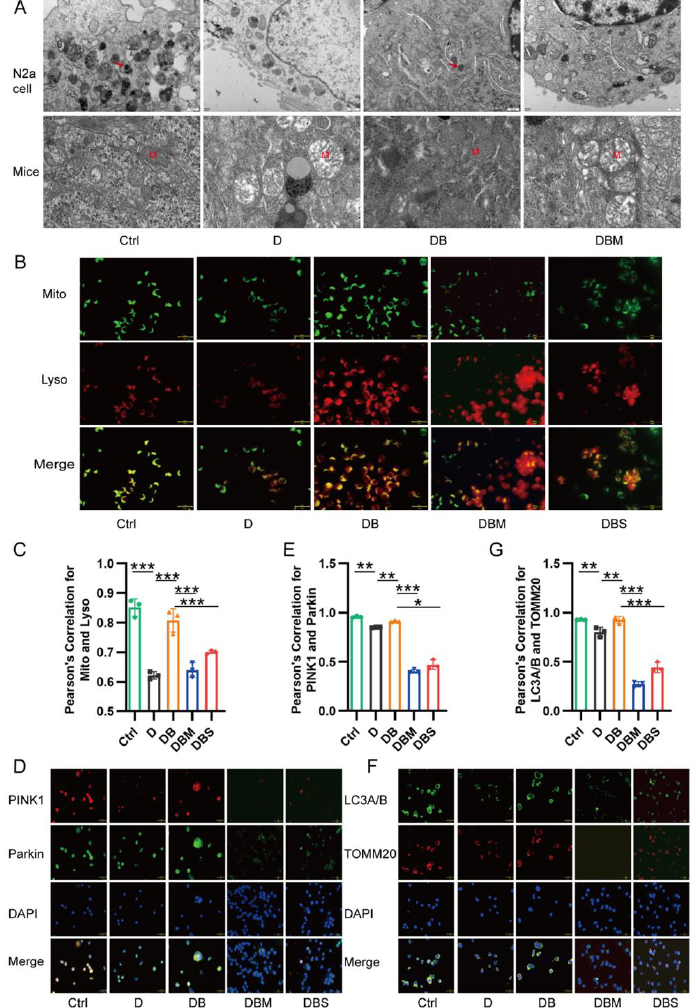
Figure 2. Berberine antagonized D-ribose-induced inhibition of mitophagy. Mitochondria of the D and DBM groups were swollen and cristae were ruptured ( A ). Berberine boosted the colocalization proportion of mitochondria and lysosomes ( B , C ). Compared with the Ctrl group, the colocalization of LC3A/B and TOMM20 ( F , G ), and PINK1 and Parkin ( D , E ) in the D group was significantly reduced, which blocked PINK1–Parkin-induced mitophagy. Electron microscopic evaluation of mitophagy in N2a cells and hippocampus. Red arrows indicate autophagic vesicles. M, mitochondria. Scale bar = 2 µ m ( A ). N2a cells showing colocalization of mitochondria with lysosomes. Lyso: lysosome; and Mito: mitochondria ( B , C ). Immunofluorescence costaining of PINK1 and Parkin to detect colocalization ( D , E ). Immunofluorescence for LC3A/B and TOMM20 showing co-localization ( F , G ). Scale bar = 5 µ m. * p < 0.05, ** p < 0.01, *** p < 0.001. Abbreviation: Ctrl, Control; D, D-ribose; DB, D-ribose + BBR; DBM, D-ribose + BBR + Mdivi-1; DBS, D-ribose + BBR + si-PINK1. Mito Tracker (green) and lyso Tracker (red) were then used to observe the fusion